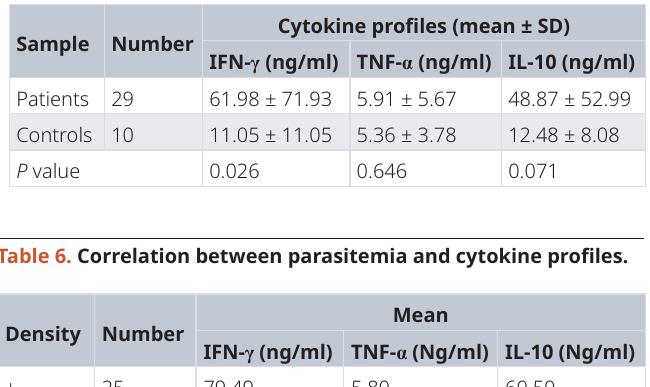
Table 5. Cytokine profiles of the study